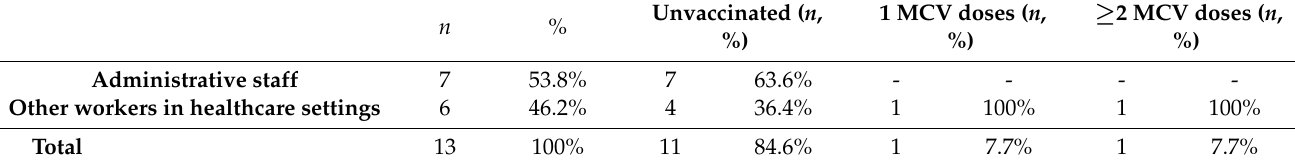
Table 4. Measles cases reported in healthcare settings, by professional group and vaccination status. Spain, 2014–2020. Healthcare Workers (HCW)